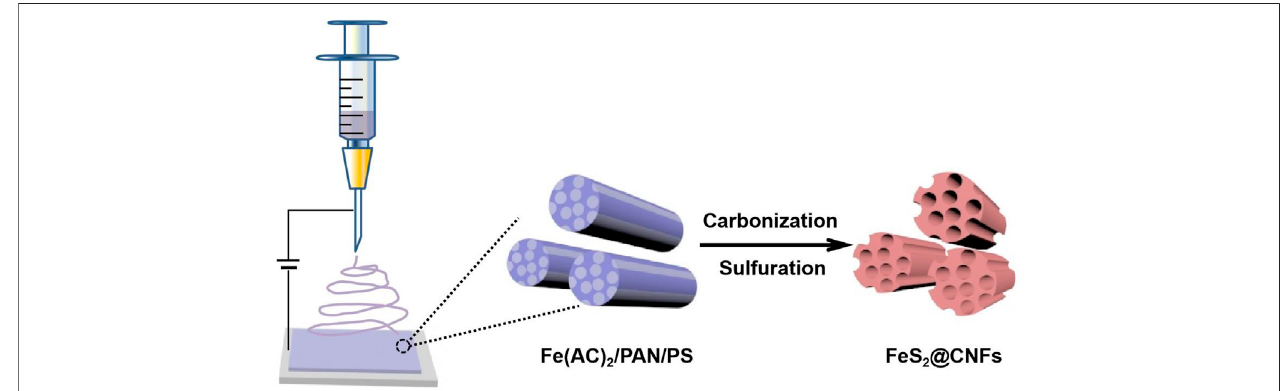
FIGURE 1 | Illustration of the procedure for the preparation of